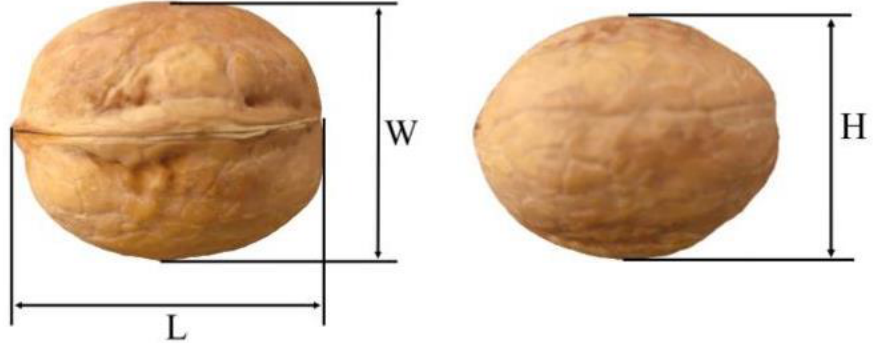
Figure 1. Three-dimensional geometric size of walnuts.